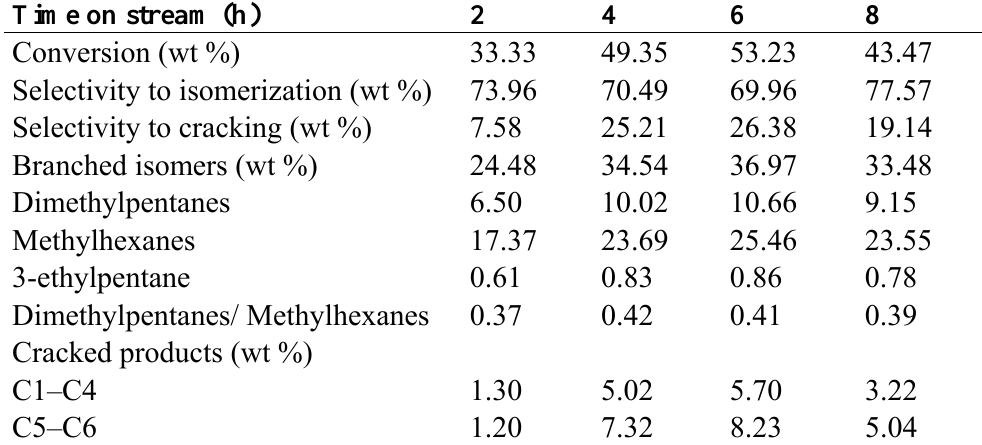
Table 3. Isomerization of n- heptane over Pt/SZ catalyst (473 K, 18.5 bar).